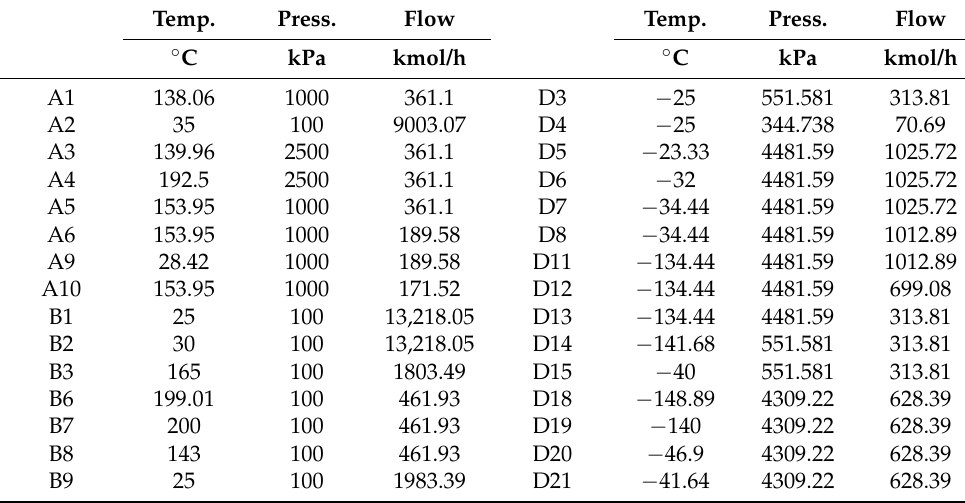
Table A4. The used streams thermodynamic characteristics.